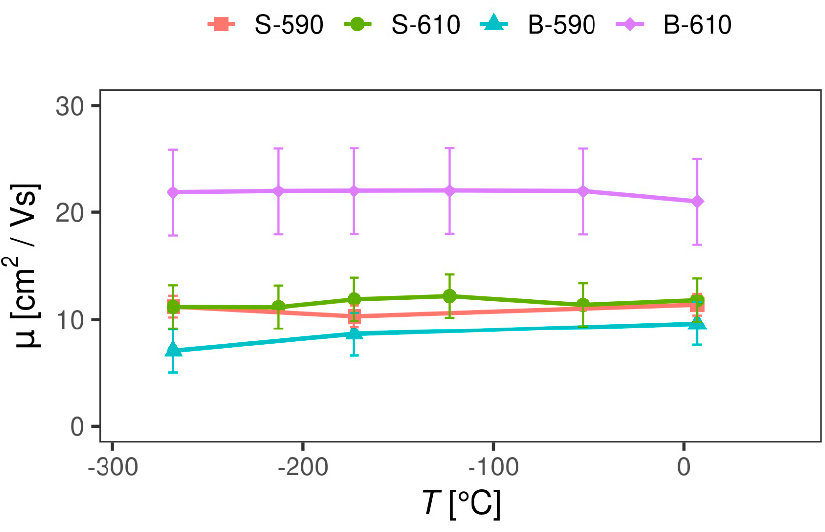
Figure 8. Charge carrier mobility of SnO 2 samples as a function of temperature.